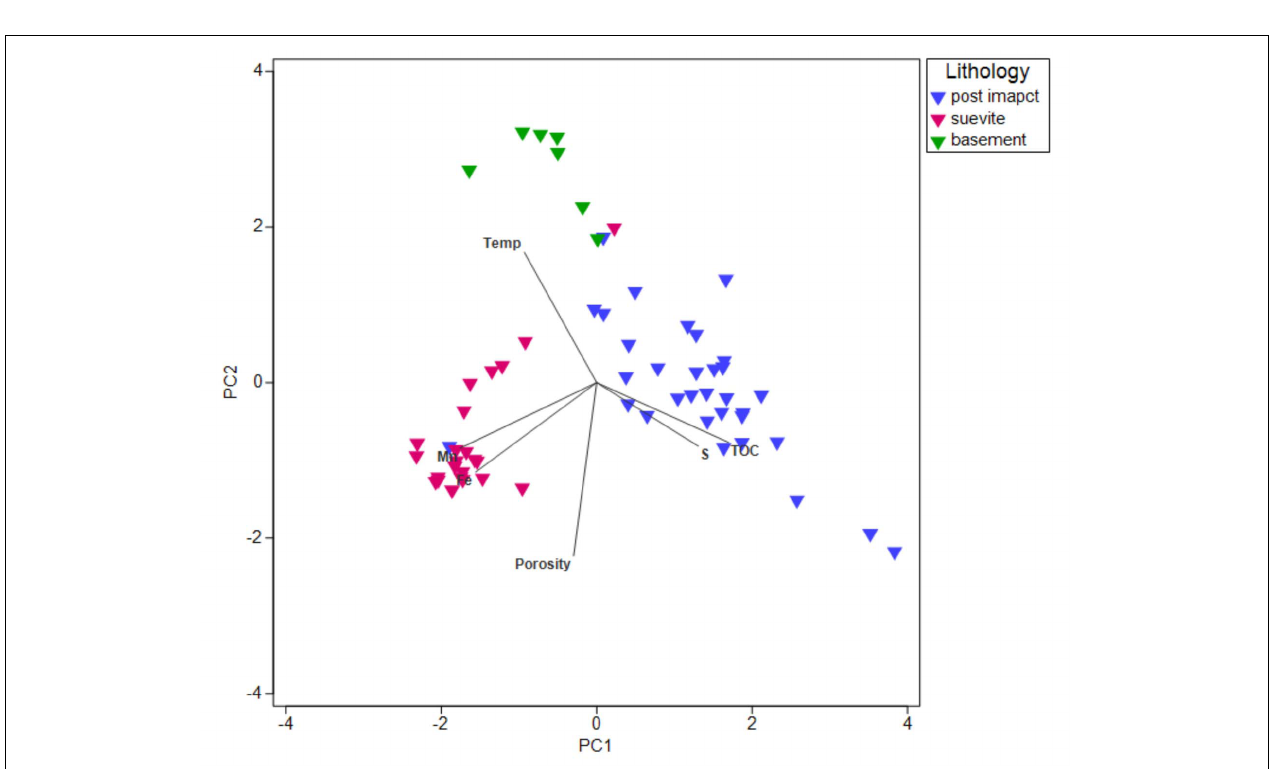
FIGURE 7 | PCA plot based on SIMPER analysis of environmental parameters (porosity, TOC, temperature, Fe, S, and Mn). Vectors overlay represents each of these parameters contributing to each lithological interval.